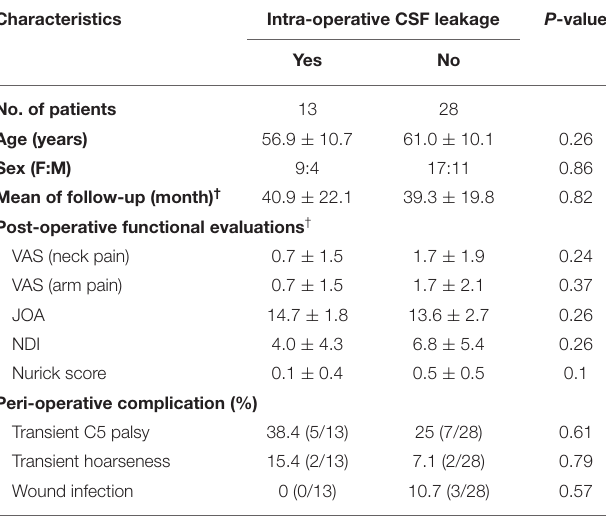
TABLE 2 | Pre- and post-operative clinical characteristics. Characteristics